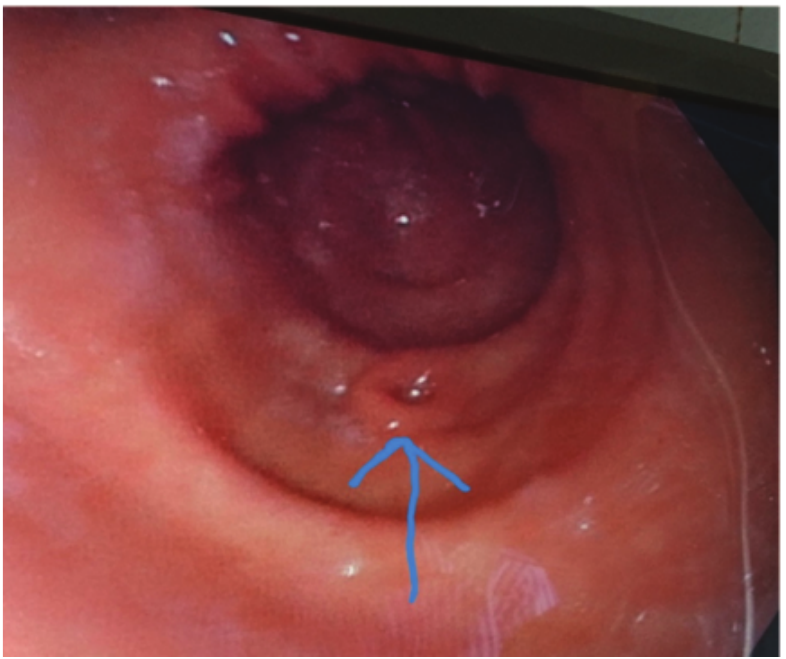
Figure 1: OGD showing a firm, circular, umbilicated subepithelial antral nodule.